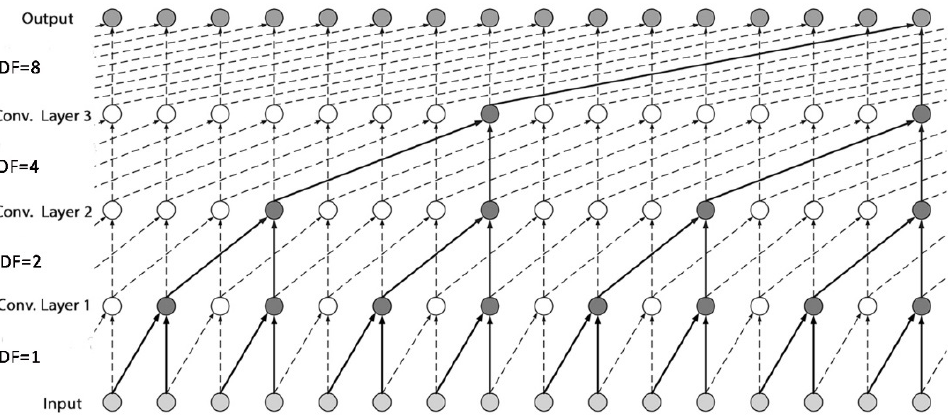
Figure 6. Temporal convolutional neural network. The dilation factor (DF), or receptive field enlargement with gaps in entries of sub- sequent convolution layers, is increased exponentially to achieve large receptive field sizes. Since TCN does not perform recurring calculations, it is more robust with respect to vanishing and exploding gradients than any RNN network. It is more computationally and memory efficient. More detailed information about TCN can be found in